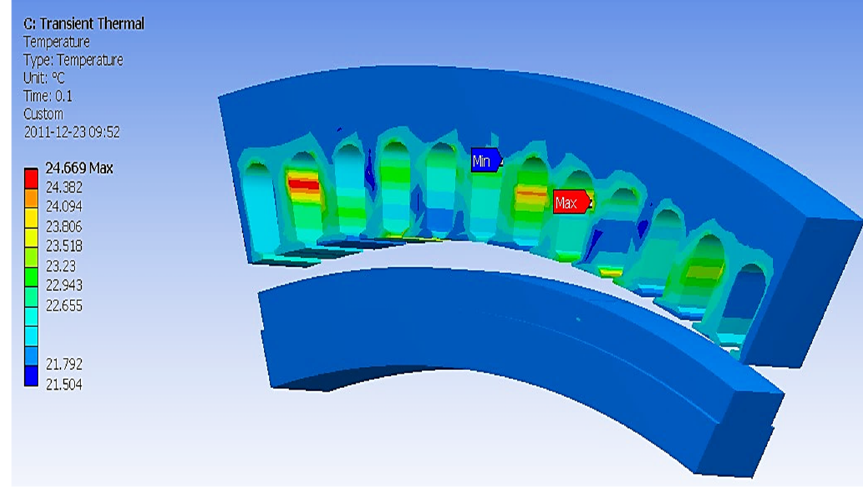
Figure 12. Temperature distribution of stator and windings